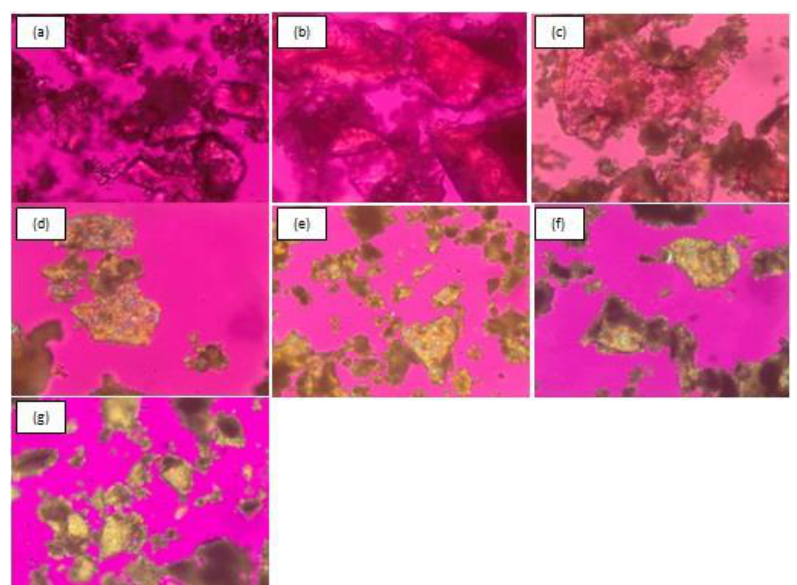
Figure 4. Polarized light microscopic images (magnification 400x) of crystal growth from a co-amorphous desloratadine-benzoic acid (DES–BA) system for stability studies after storing at 40 °C under 75% RH and measured after specified periods of time: fresh prepared ( a ), 3 days ( b ), 8 days ( c ), 17 days ( d ), 30 days ( e ), 45 days ( f ) and 90 days ( g ).